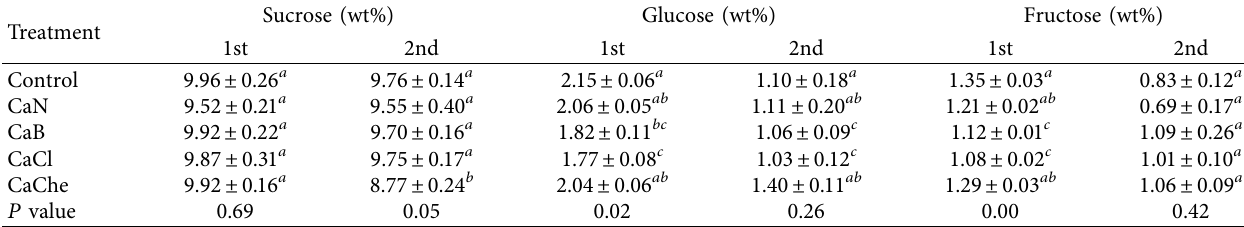
Table 5: Effect of calcium sprays on sucrose, fructose, and glucose in fruit flesh.